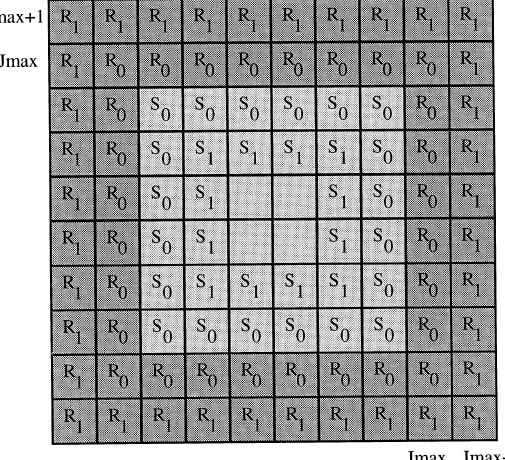
Fig. 4. To compute two barotropic timesteps, without requiring message passing, an extra outer halo, R 1 , must be declared for receiving data from the inner halo, S 1 . The halo, R 0 , can then be stepped forward on the first of the two timesteps, so that the halo, S 0 , can be calculated successfully in the